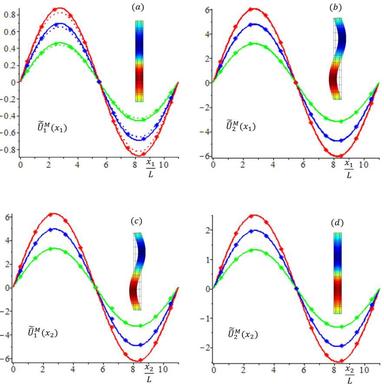
Dimensionless transformed macro-displacement component ˜ Uˆ M α (xβ ) induced by transformed body force bˆα (xβ ) with α = 1, 2 and β = 1, 2: (a) ˜ Uˆ M 1 (x1 ); (b) ˜ Uˆ M 2 (x1 ); (c) ˜ Uˆ M 1 (x2 ); (d) ˜ Uˆ M 2 (x2 ). The solution given by the homogenized model 1 (continuous curves) and the homogenized model 2 (dotted curves) are compared with the solution given by the heterogeneous one (diamonds). The red curves are given for the dimensionless parameter sς = −2, the blue curves for sς = −0.5 and the g